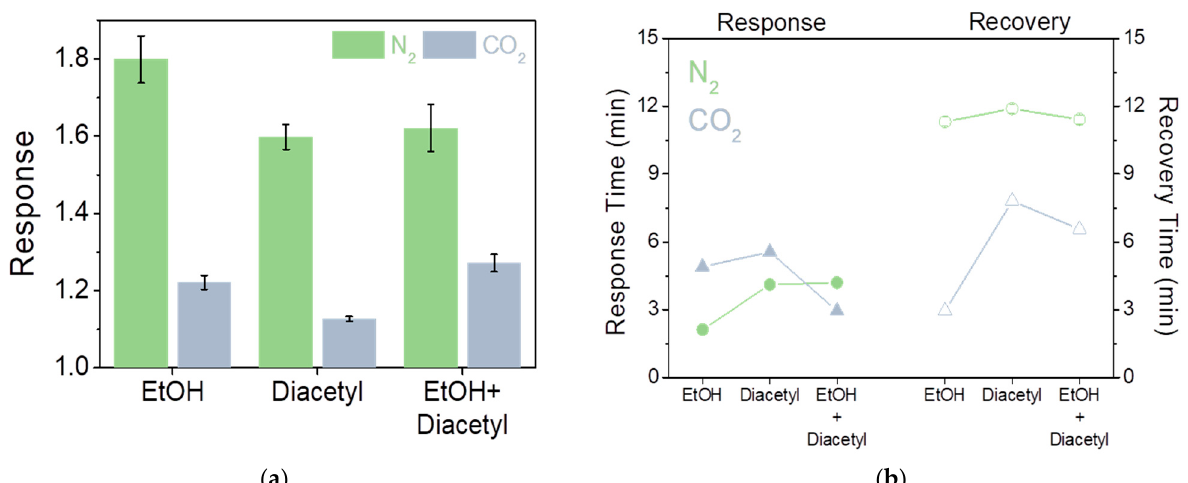
Figure 4. ( a ) Sensor response in N 2 and CO 2 to alcoholic (5% ethanol) solution, aqueous diacetyl solution (0.4 mg/L) and alcoholic (5% ethanol) diacetyl solution (0.4 mg/L). Error bars are calculated on three runs; ( b ) response and recovery times of sensor exposed at different concentration of diac- etyl in aqueous and alcoholic solutions in CO 2 and N 2 ambient. Error bars are calculated on three